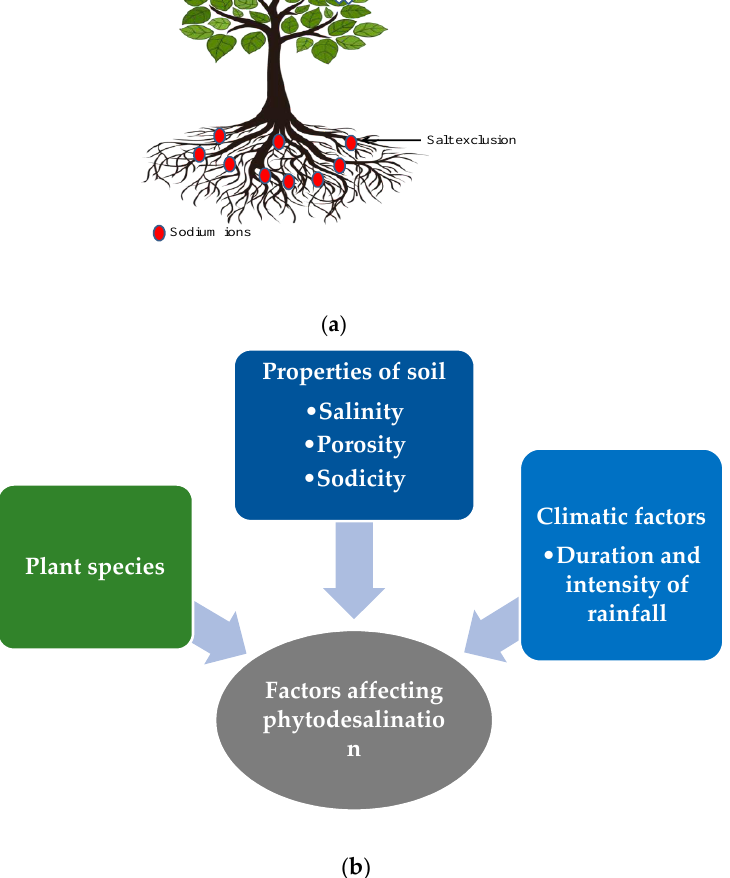
Figure 6. Phytodesalination process: ( a ) mechanism of phytodesalination and ( b ) factors affecting the mechanism of phytodesalination.